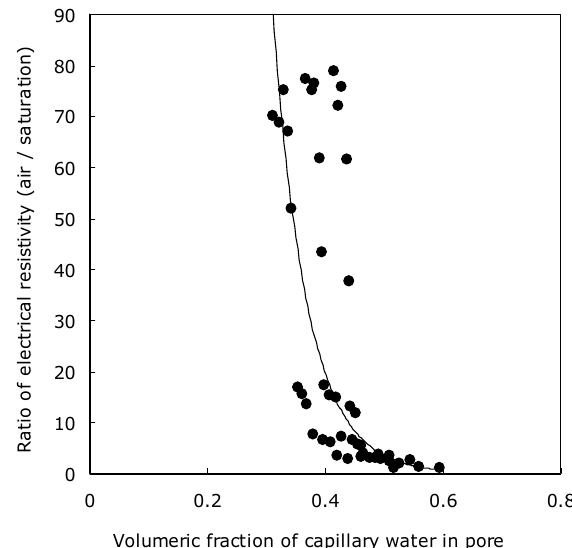
Figure 7. Relationship between the electrical resistivity of the concrete and the volumetric fraction of the capillary water in the pores.